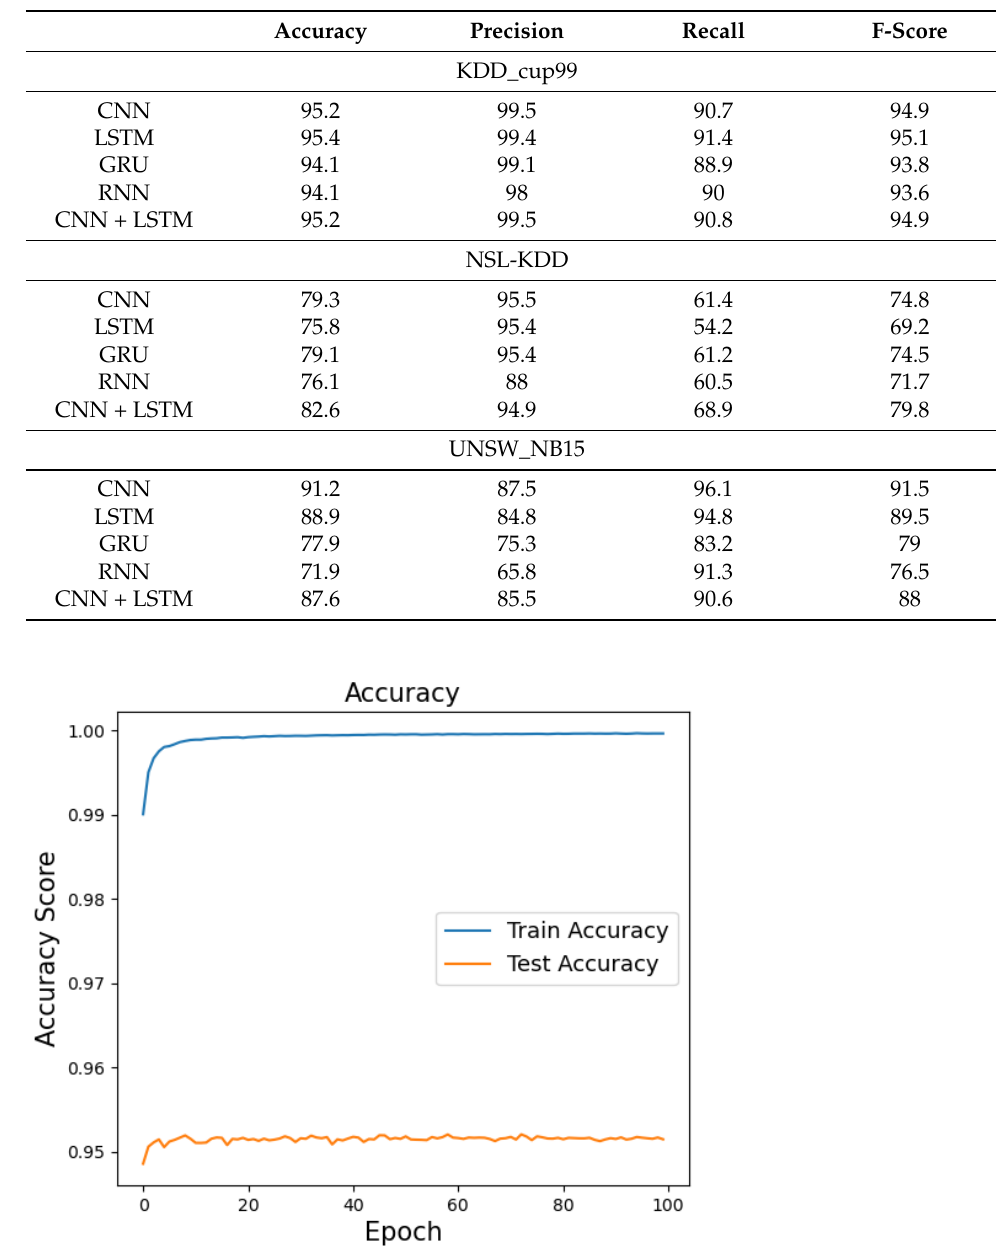
Table 3. Second Experiment Results.